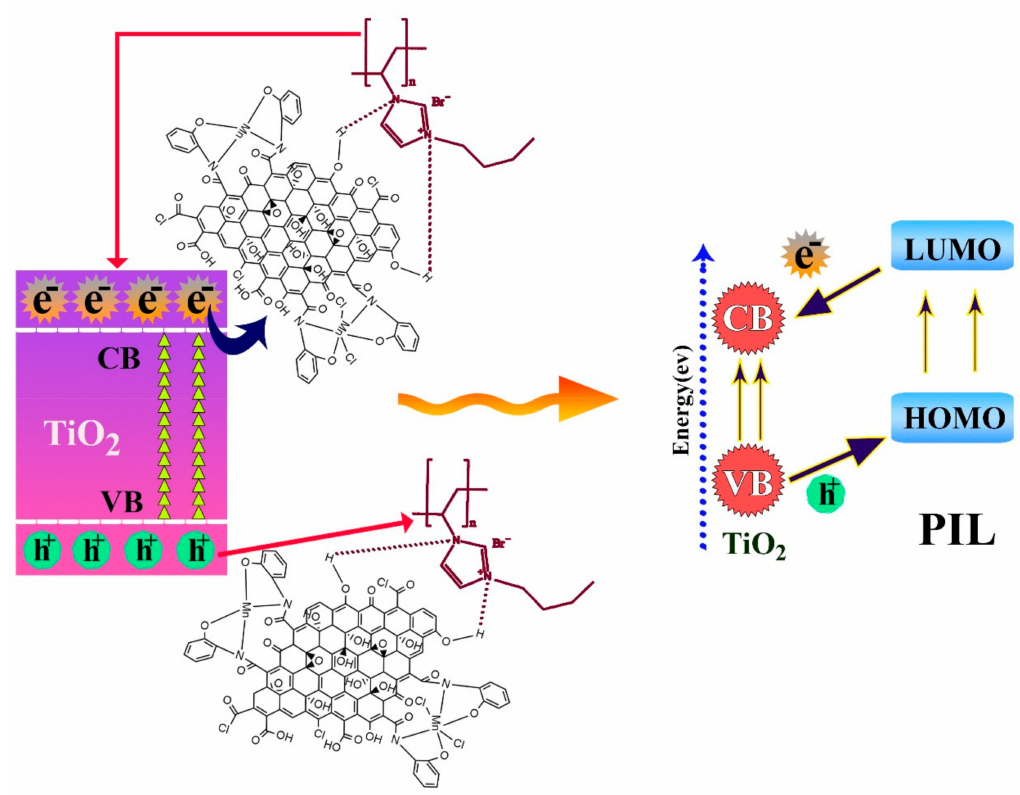
Figure 1. Schematic illustrating photocatalytic degradation with the help of band structures. MengWang et al. and coworkers were reported beyond 90% degrading yields for benzene and toluene during 1 and 2 h, respectively, by CDs/CdS-TiO 2 nanocomposites. While the CDs/CdS-TiO 2 ’s bandgap hit the point of 2.28 eV [39], our newly synthesized PIL(low)@TiO 2 @m-GO nanocomposite obtained a high degradation efficiency of 97% for benzene and toluene within 24 min. The bandgap energy of PIL(low)@TiO 2 @m-GO